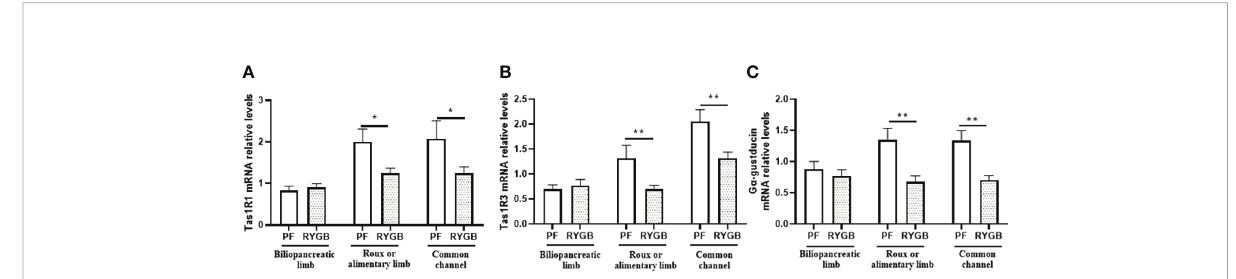
FIGURE 5 Effect of RYGB on intestinal taste receptor and a -gustducin mRNA. On POD 21, segments from the biliopancreatic limb (BP), Roux limb and common channel (CC) were harvested from RYGB rats along with corresponding segments from PF rats. Mucosal Tas1R1 (A) , Tas1R3 (B) and a - gustducin (C) mRNA were measured by RT-PCR. Data are mean ± SE, n=11-13 per group, *p<0.05, **p<0.01.